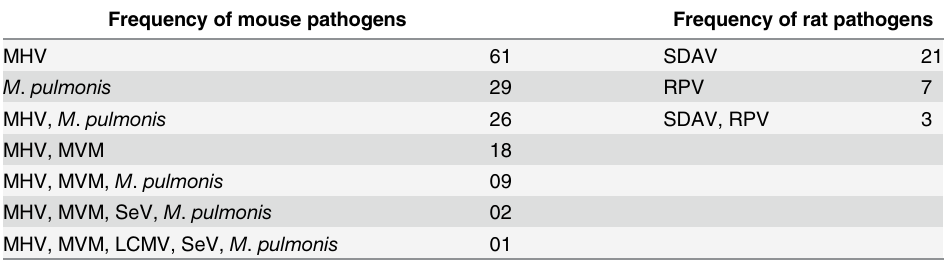
Table 2. Prevalence (no. of positive samples) of multiple infections in mice and rats.